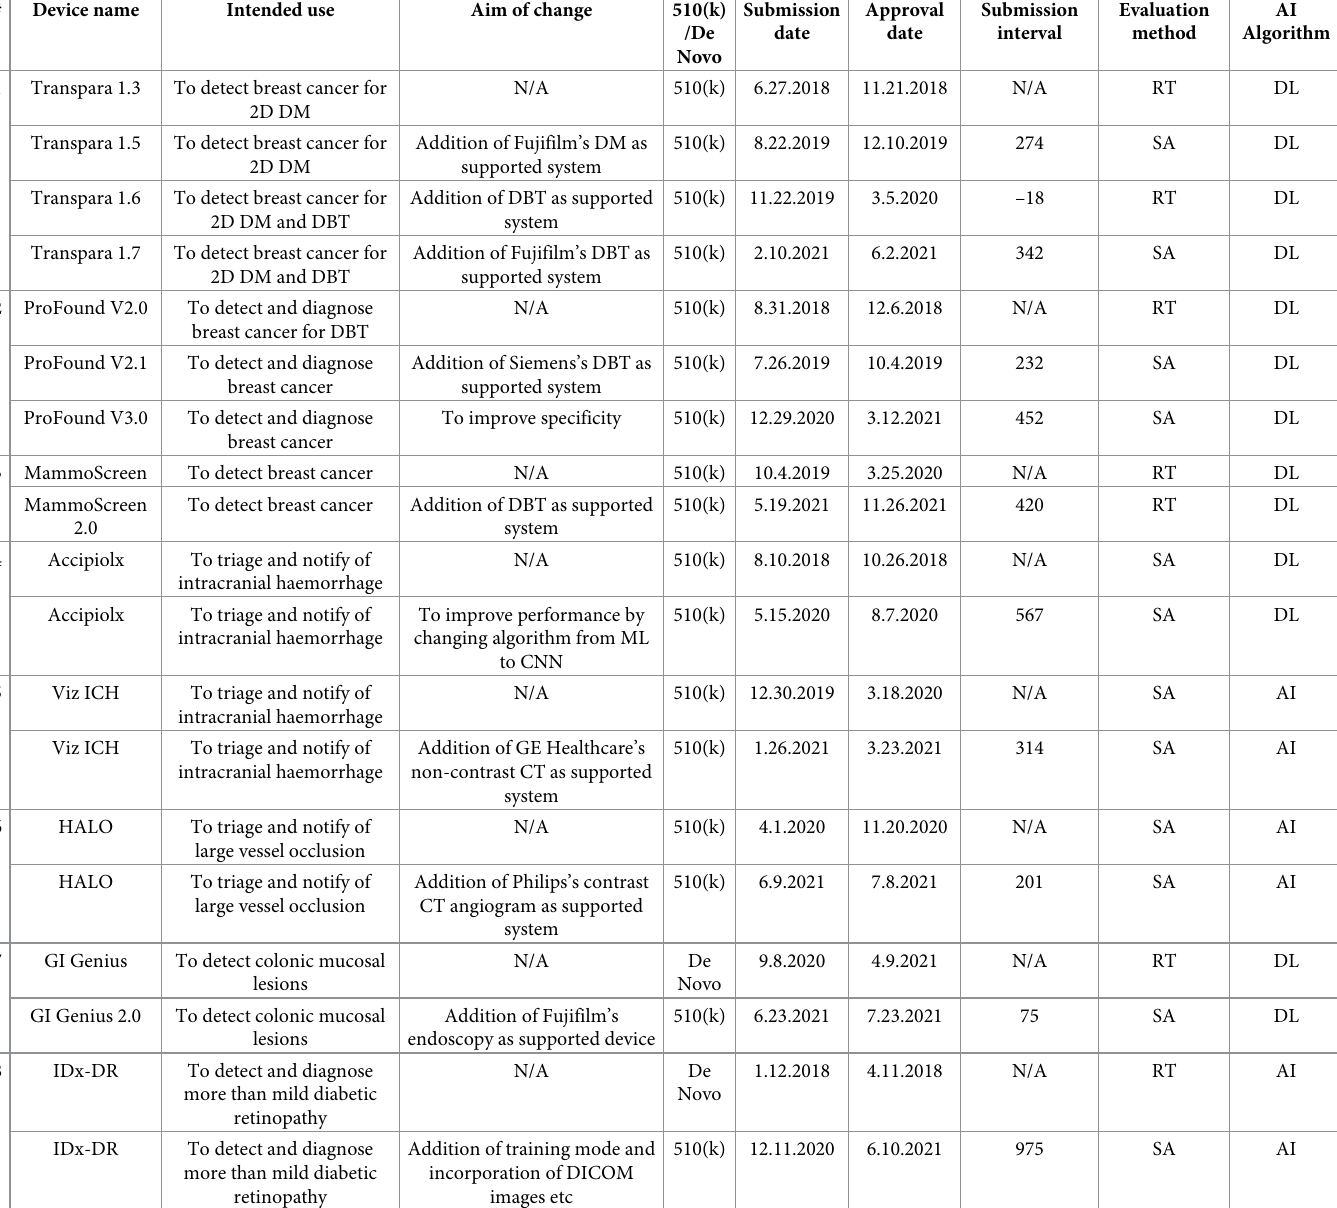
Table 1. Characteristics of the 8 devices improved at post-market in the USA. RT, Reader study testing; SA, Software standalone testing; DL, Deep learning. Submis- sion interval = Submission Date -Approval